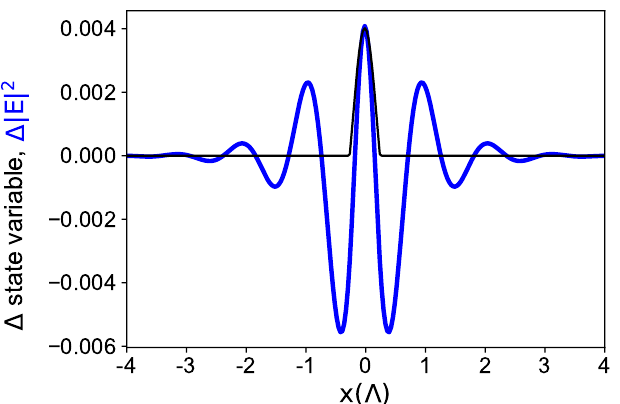
Figure 17. Perturbation of atomic state variable (black line) proportional to refractive index and resulting perturbation (scaled to meet perturbation amplitude for purpose of visualization) in intra- cavity intensity after a time corresponding to five times the inverse of the cavity decay rate (see text and Figure 15 for details of the procedure). Parameters: pump intensity 1.05 above threshold; cavity detuning zero, ∆ = − 10 Γ , cooperativity parameter C =